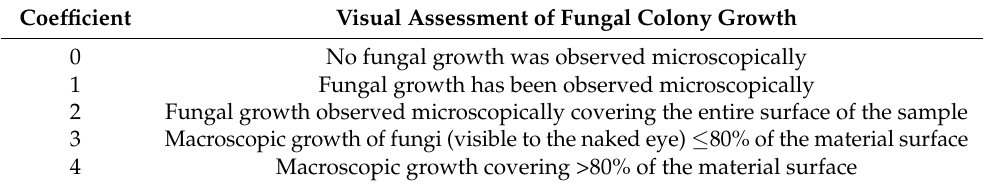
Table 4. Fungal colony growth expert rating scale.